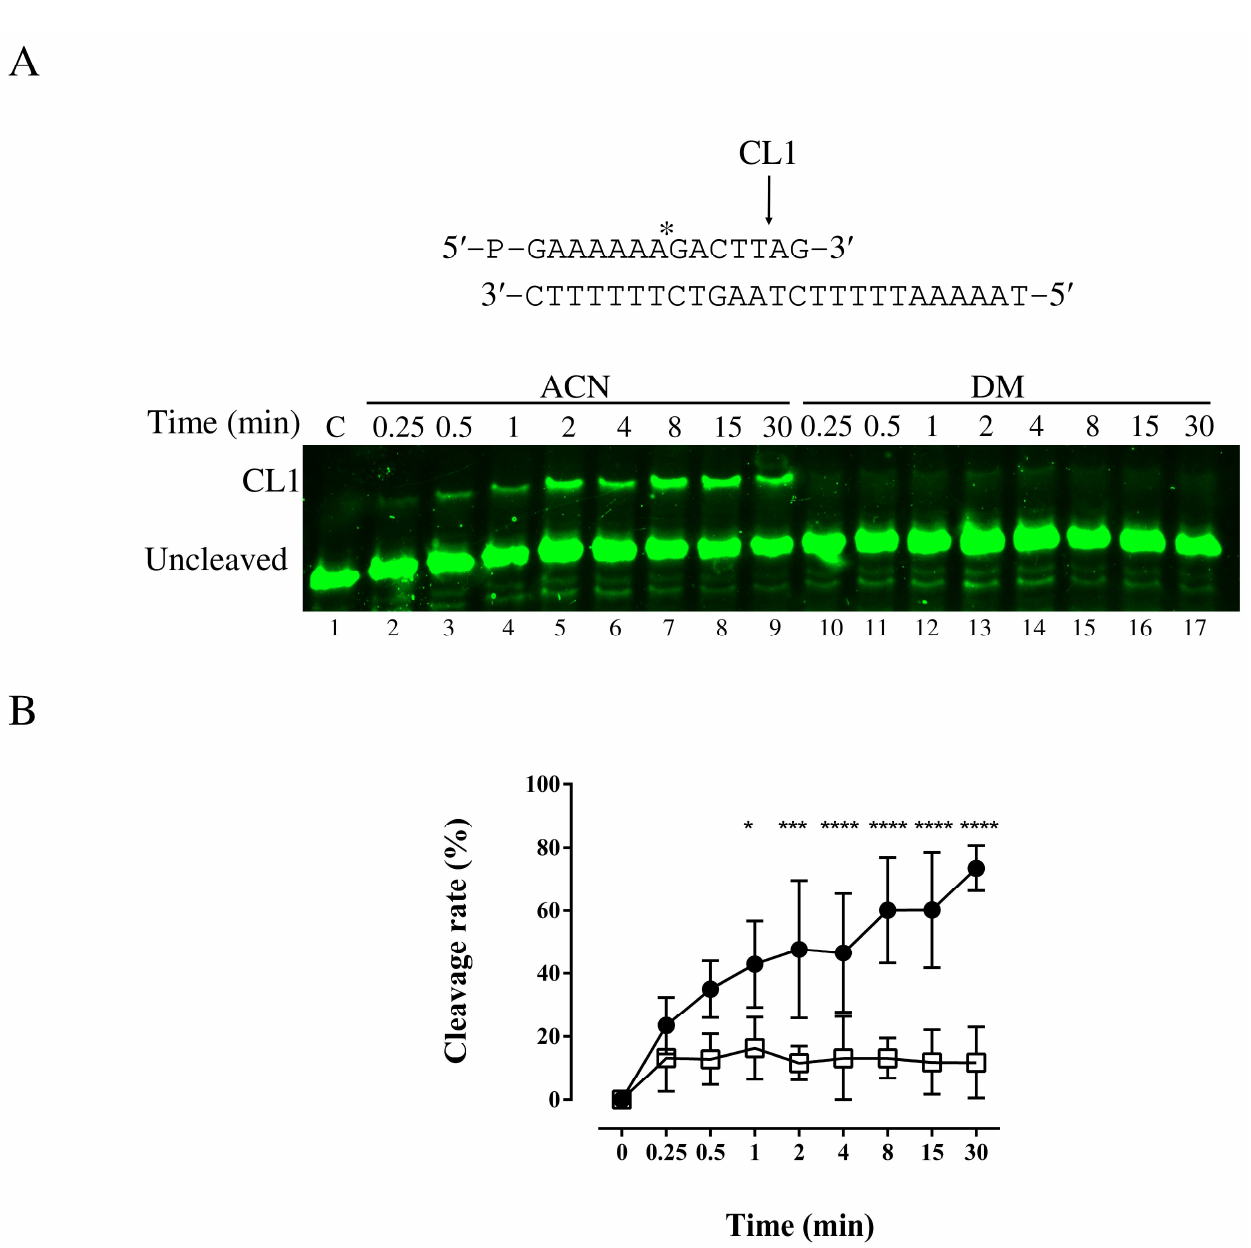
Figure 3. Analysis of Cleavage of the hTop1 catalytic mechanism on the fluorescently labeled SS. ( A ) Cleavage assay of hTop1 in the absence and presence of DM. Top panel is a schematic representation of SS, the bottom panel is a denaturing polyacrylamide gel. Samples were incubated at 25 ◦ C in the absence and presence of 100 µ M and the reaction was stopped at different time points with 2.5% SDS. Samples were resolved on a denaturing polyacrylamide gel and visualized by ChemiDoc MP imaging system. CL1 cleaved strand, C is the negative control. ( B ) Plot of the percentage of the cleavage rate as function of time. Black circles represent the enzyme incubated in the presence of ACN while the white squares reported the effect of DM at 100 µ M. The plot reports the cumulative data of four independent experiments with mean ± SD values. Asterisks indicate * p ≤ 0.05, *** p ≤ 0.001, **** p ≤